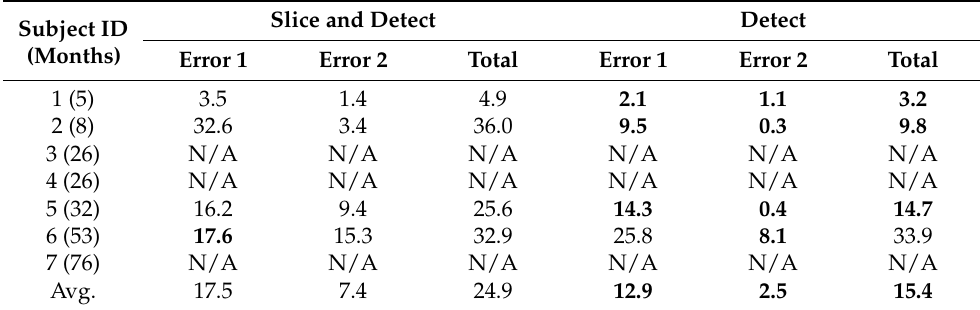
Table 1. Performance of Both Algorithms on Group #1.